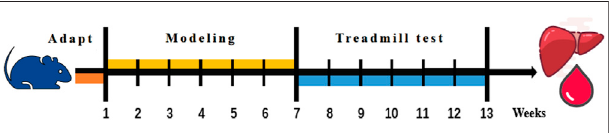
FIGURE 1 | Experimental